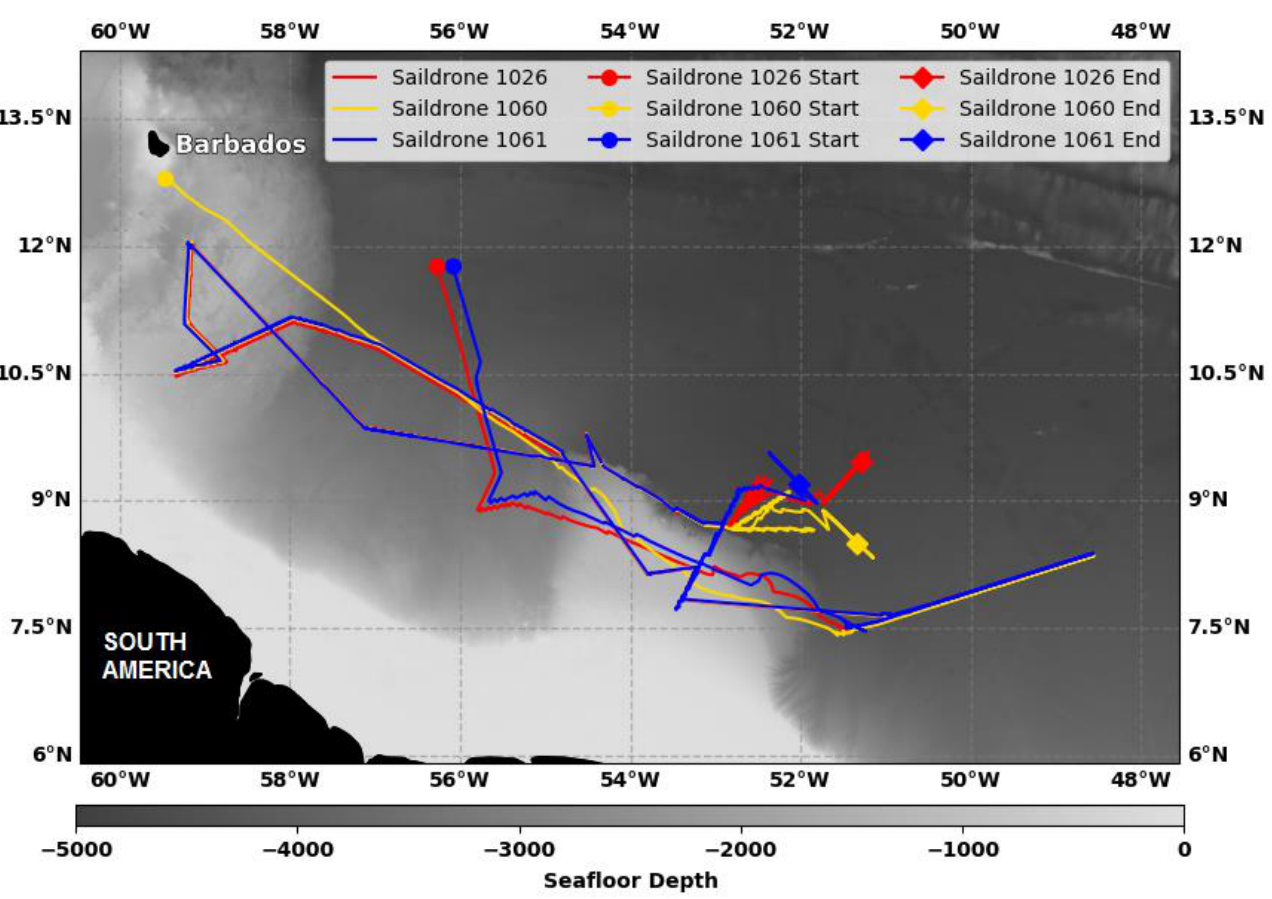
Figure 3. The tracks of the three NASA saildrones within the EUREC 4 A-OA study area. The start (17 January 2020) and end (2 March 2020) points of each track are shown by a circle and diamond, respectively. Bathymetry Data from The General Bathymetric Chart of the Oceans (GEBCO) (available at https://download.gebco.net/ (accessed on 27 June 2022) is shown behind the saildrone tracks. The saildrone data files collected at a 1 min temporal resolution over the duration of the measurement period include platform telemetry and near-surface observational data (see https://podaac.jpl.nasa.gov/dataset/SAILDRONE_ATOMIC, accessed on 30 April 2021). The utilization of the saildrone platform represents a new and evolving trend in scientific sampling campaigns in which the data collection platform and process are subcontracted to Saildrone Inc. who is responsible for executing the experiment design and assuring the quality of the data. Hence, it is important to independently assess the accuracy of the data provided by the Saildrone